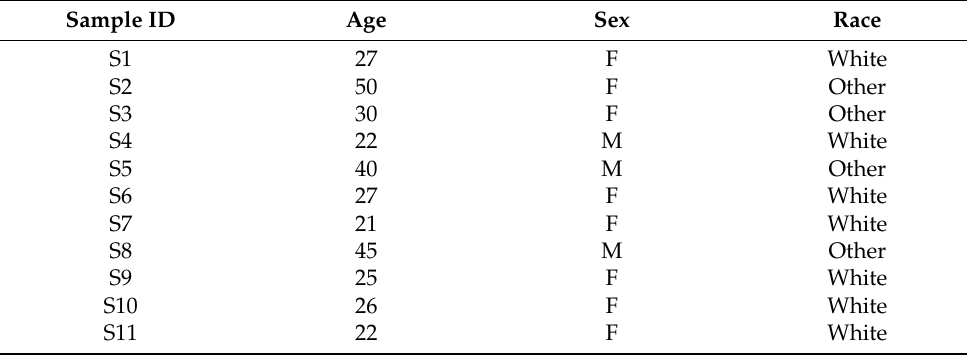
Table 1. Demographic characteristics of healthy subjects included in this study.